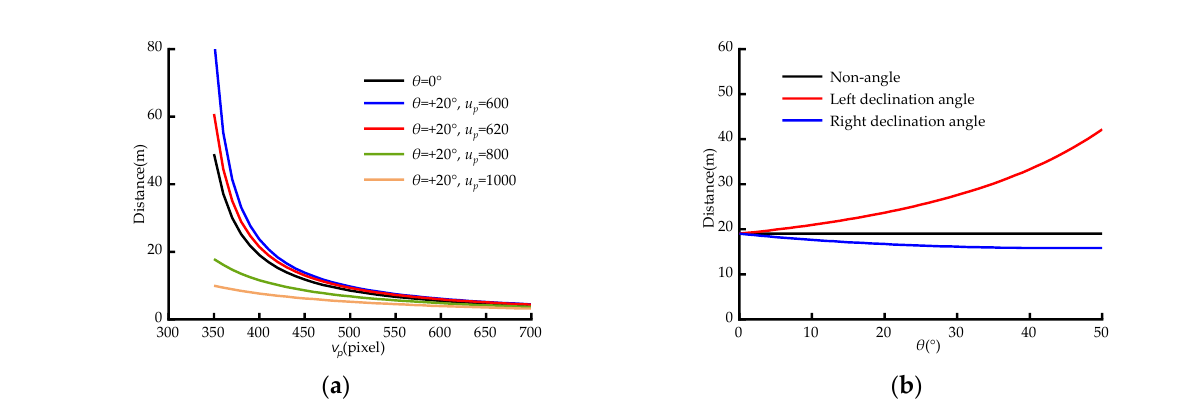
Figure 7. Simulation results. ( a ) Change of ranging result with vehicle position; ( b ) Change of ranging result with θ .